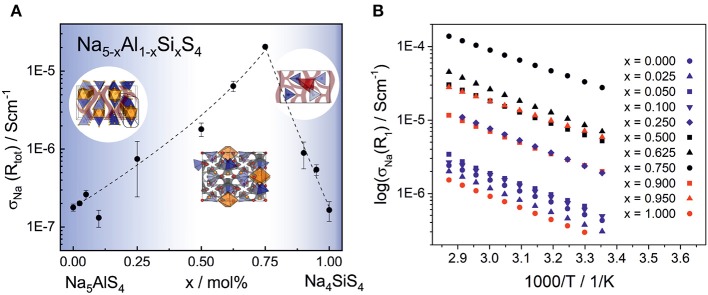
(A) Sodium ion conductivity in the phase system Na5-xAl1-xSixS4 with (0 ≤ x ≤ 1) as a function of the substitution factor x (visualized by dashed line). In the range of x = 0.50–0.75, where the material crystallizes in the Na9(AlS4)(SiS4)-structure, the highest average conductivity of 2.04 · 10−5 S cm−1 was observed. The unsubstituted phases Na5AlS4 and Na4SiS4 show a significantly lower ionic conductivity of 1.64 · 10−7 -1.77 · 10−7 S cm−1, respectively. The error bars include the standard deviation of the sample and the error of the measurement of about 8%. (B) Temperature dependent sodium ion conductivities calculated from R1 of all phases for a selection of measurements (all parameters for these particular measurements are given in Tables S12, S13). The different colors indicate the different crystal structures: Na5AlS4-structure (blue), Na9(AlS4)(SiS4)-structure (black), and Na4SiS4-structure (red).